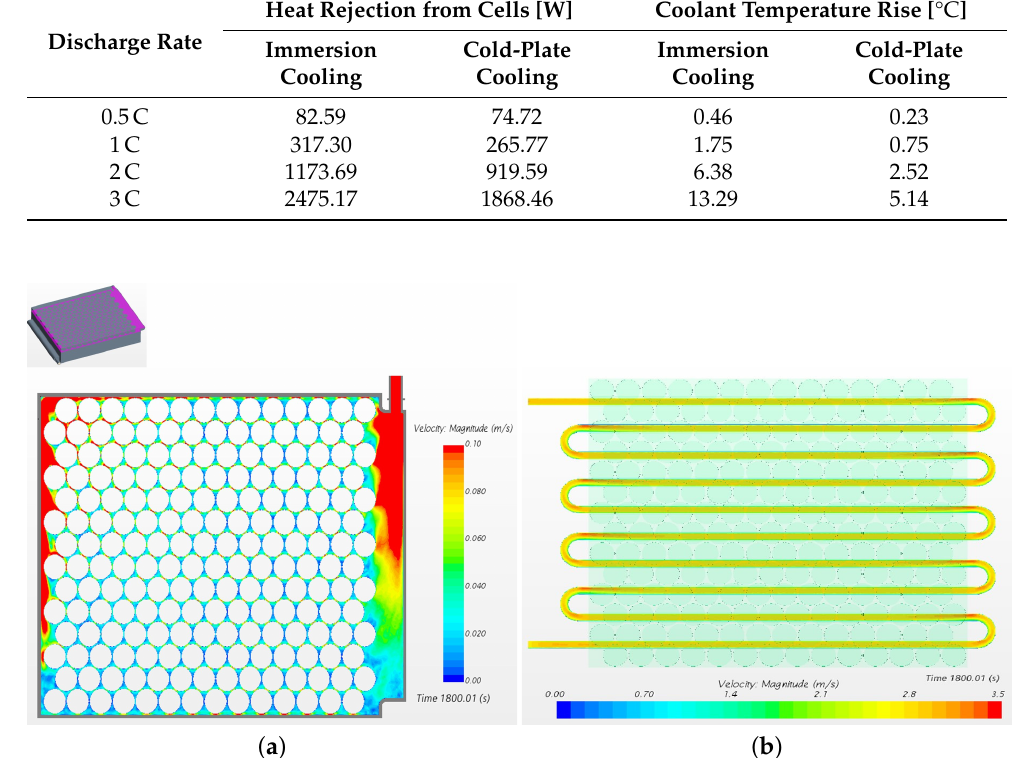
Figure 11. Contours of coolant velocity magnitude in (m/s) along ( a ) the exit plane within the immersion-cooled module, and ( b ) the vertical mid-plane through the cold-plate copper